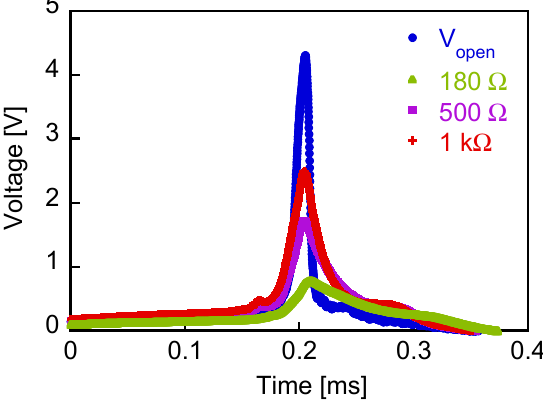
Figure 4. Experimentally measured waveforms of the open-circuit voltage and output voltages.